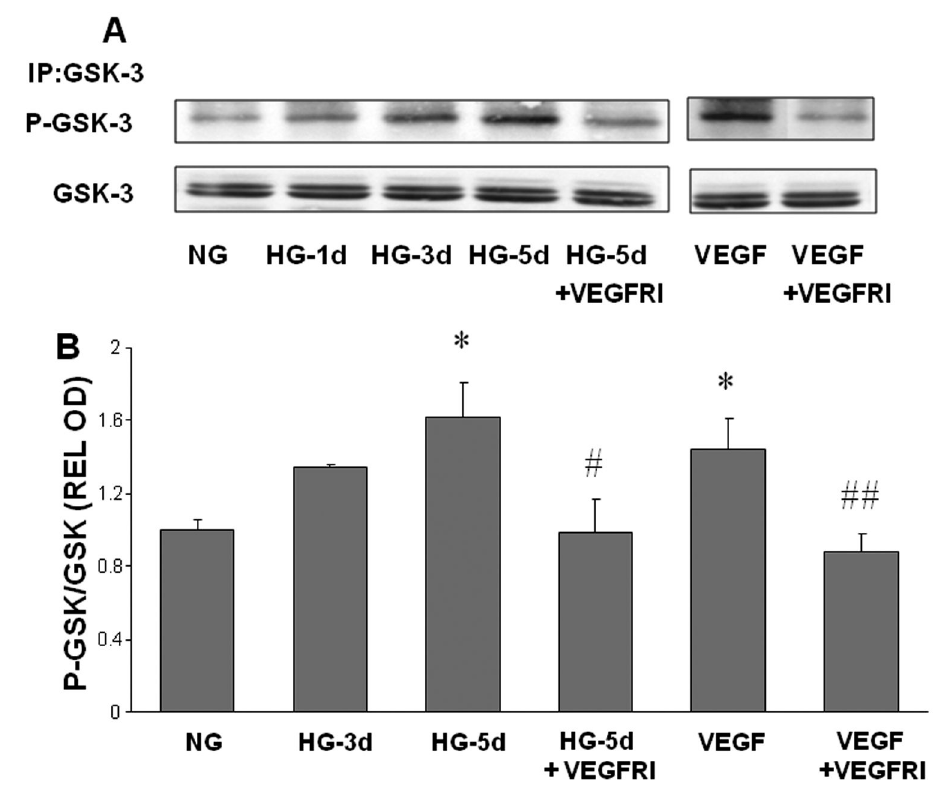
Figure 4. High glucose-induced phosphorylation of GSK3β. Endothelial cells were grown in serum-free medium containing normal glucose (NG, 5.5 mM) or high glucose (HG, 25 mM) with or without VEGFR inhibitor (VEGFRI) for 1 to 5 days. Equal amounts of SDS extracted protein samples were immunoprecipitated (IP) by anti-GSK3β antibody and subjected to SDS-PAGE and Western blotting (A). Densitometric analysis of phospho-GSK3β bands, normalized for the corresponding GSK3β bands, showed that phosho-GSK3β levels were significantly increased by HG or VEGF treatment and that this effect was reduced in VEGFI treated samples compared to HG or VEGF treated endothelial cells (B). * = P<0.05 vs NG, # = P<0.05 vs HG5, # # = P<0.05 vs